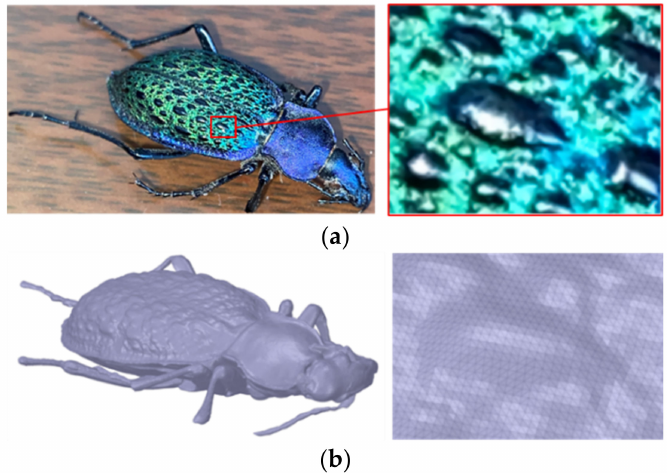
Figure 1. Geometric model of Carabus formosus nili and back convex hull: ( a ) real model and partial enlargement; ( b ) 3D reconstruction model and partial enlargement.